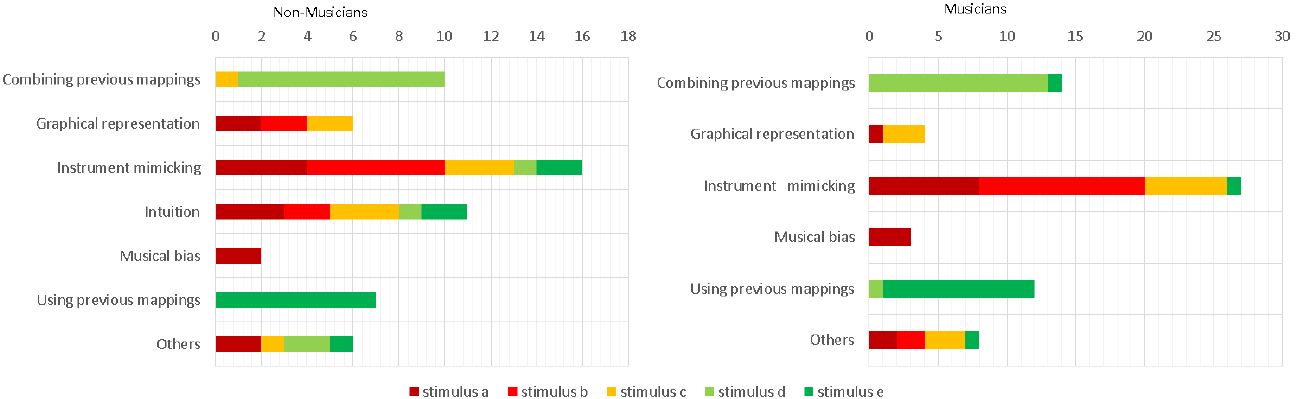
Figure 7. Frequencies of rationale evoked by participants for the gestures performed for each stimulus in phase 1. Left : Non-musician participant frequencies; Right : Musician participant frequencies; Full results reference: Tables A17–A21.